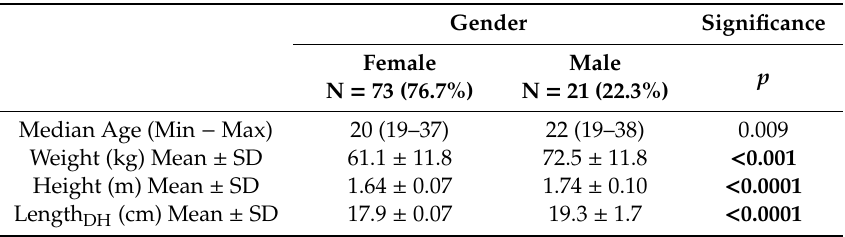
Table 1. Anthropometric characteristics.